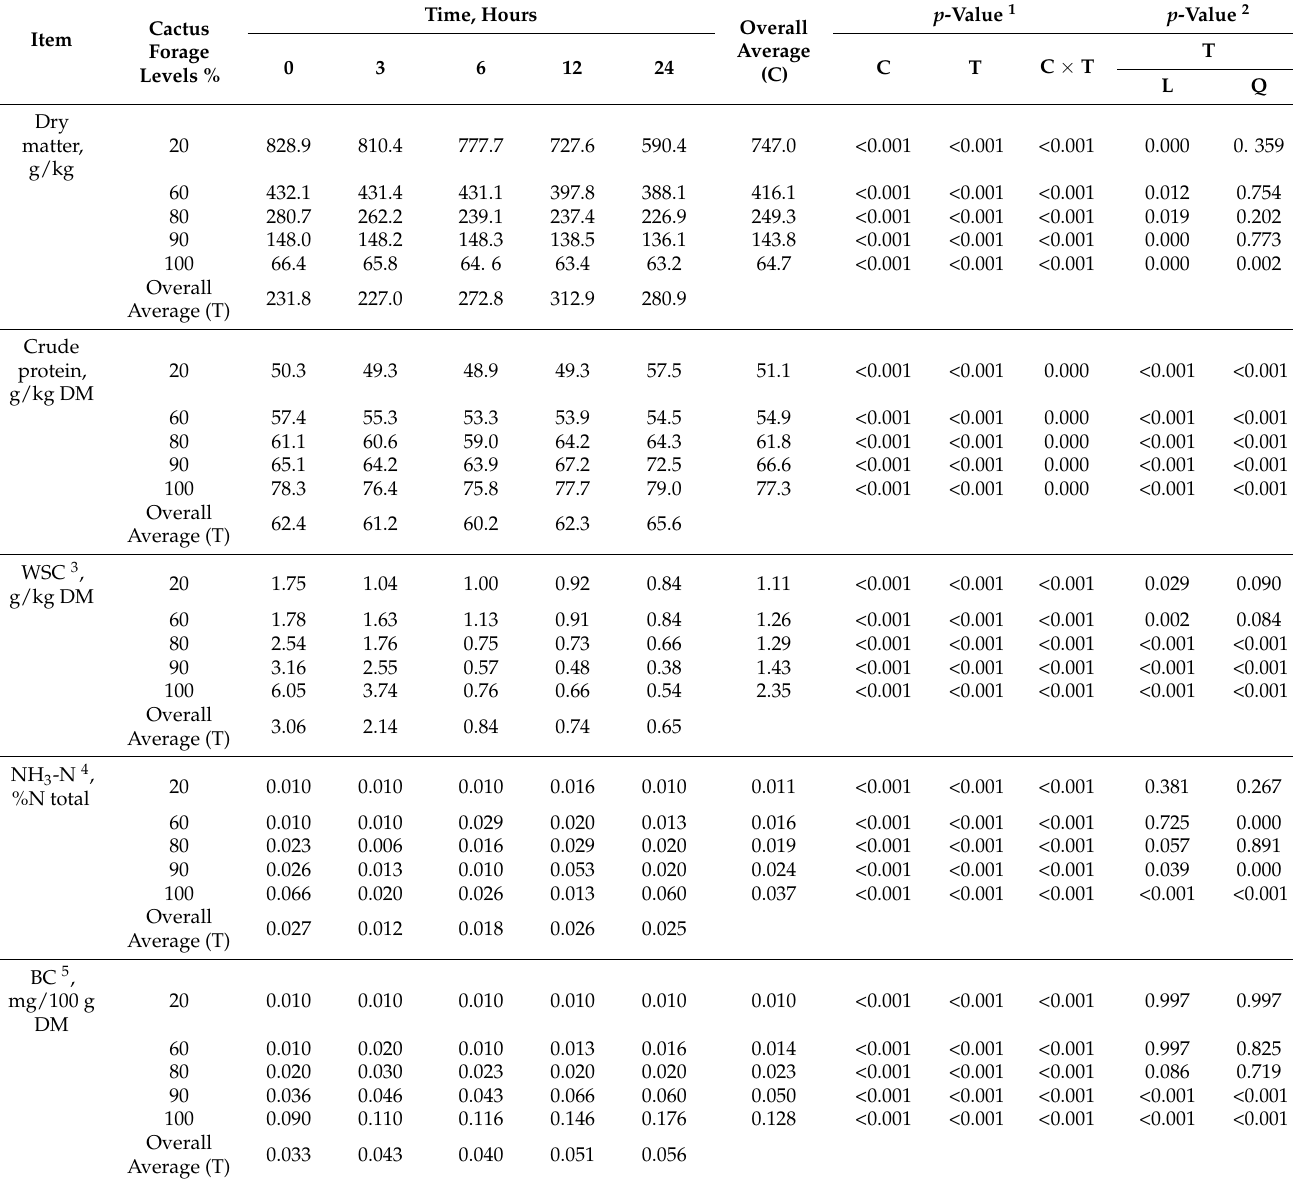
Table 3. Dry matter (DM), crude protein (CP), soluble carbohydrates (CHOs), ammonia nitrogen (N-NH 3 ), and buffering capacity (BC) as a function of cactus forage levels and time of exposure to air as dry matter